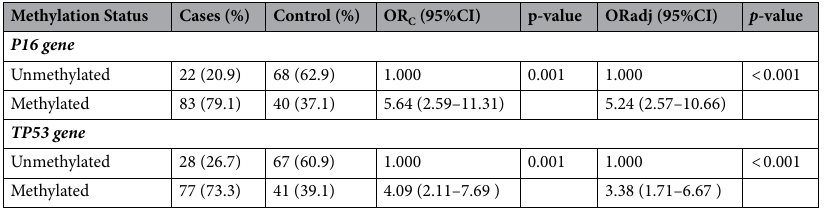
Table 2. Associations between the methylation status of P16 and TP53 and risk of oesophageal cancer. ORc: crude odds ratio, ORadj.: adjusted odds ratio, 95% CI: 95% confidence interval, P16 : (cyclin-dependent kinase inhibitor 2A), TP53 : (tumour protein p53), Adjusted for age, gender, drinking, smoking, family history of cancer, BMI, marital status, betel